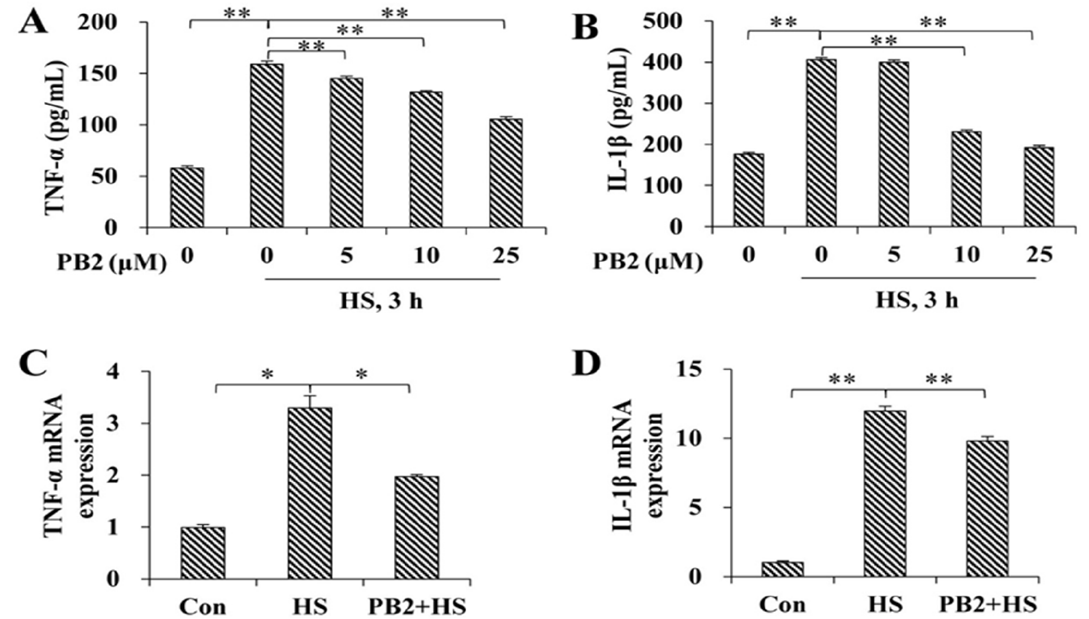
Figure 3. Effect of PB2 and HS on gene expression and release of pro-inflammatory cytokines. MAC-T cells were pre-incubated with different concentrations (0, 5, 10, and 25 µ M) of PB2 for 24 h, followed by HS treatment at 42 ◦ C for 3 h and recovery at 37 ◦ C for 6 h. Then, release of ( A ) TNF- α and ( B ) IL-1 β in culture media were investigated by ELISA kit. Additionally, after HS and recovery treatment, cells pre-incubated with or without 25 µ M PB2 were collected to detect mRNA expressions of ( C ) TNF- α and ( D ) IL-1 β . n = 3. * p < 0.05, ** p < 0.01.